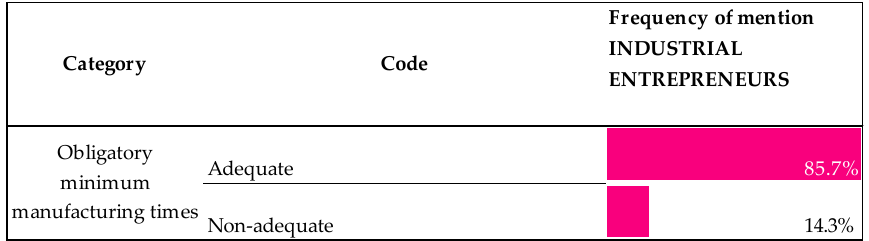
Figure 8. Industrial entrepreneurs’ views on the requirements of the QS (Quality Standard) in terms of the maturity times. (Scale: frequency of mention of each opinion. Percentage is based on responses in the given code out of all responses to equal 100%).